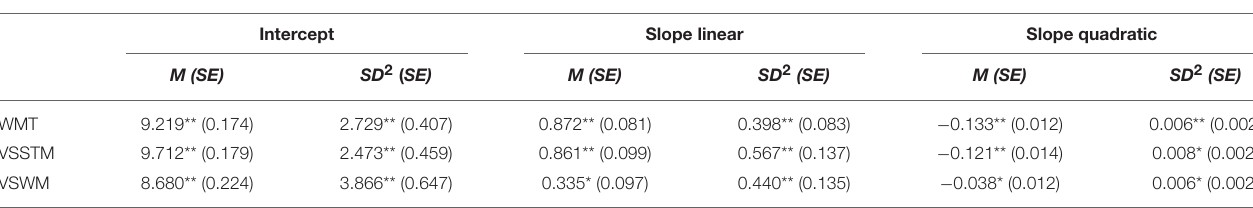
TABLE 2 | Means and variances in latent growth curve modeling